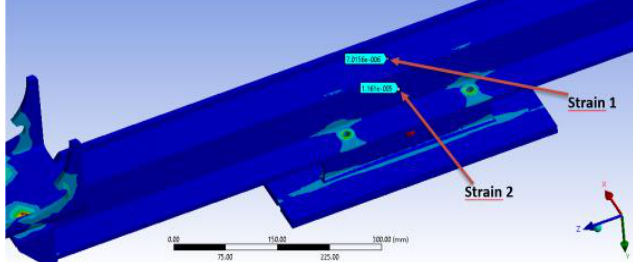
Fig. 10. Calculated strains in the area of sensors in case of the dynamic magnetic field.